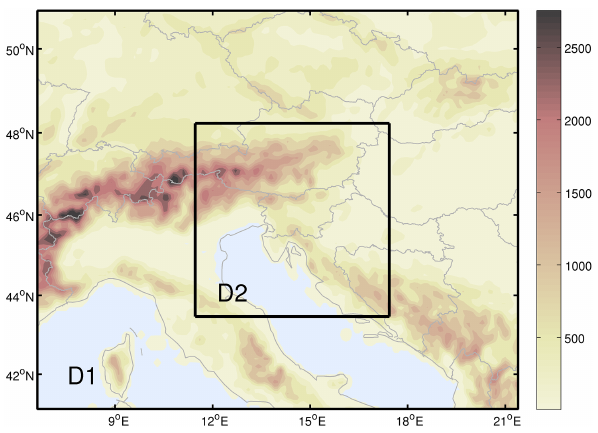
Figure 1. Modelling domains (D1, D2) used in the WRF-Chem RT- AQF system. Orography (in metres) is shown in resolution of the D1 domain